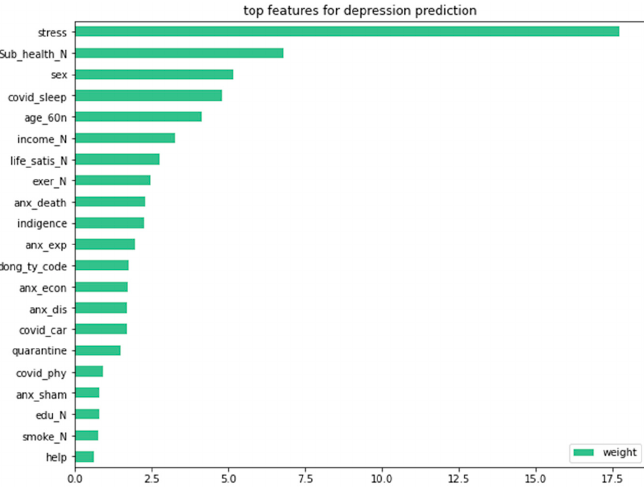
Figure 3. LIME top features for depression prediction